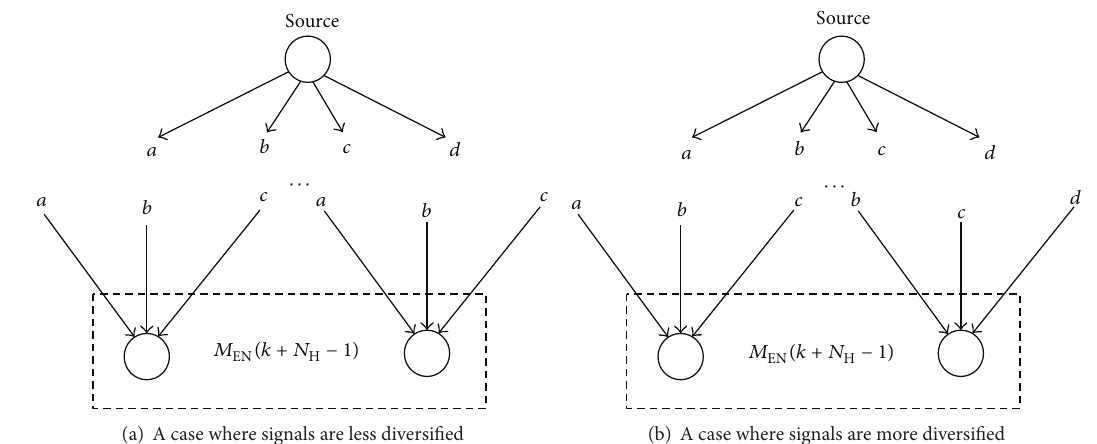
Figure 8: An illustration of signal diversification.